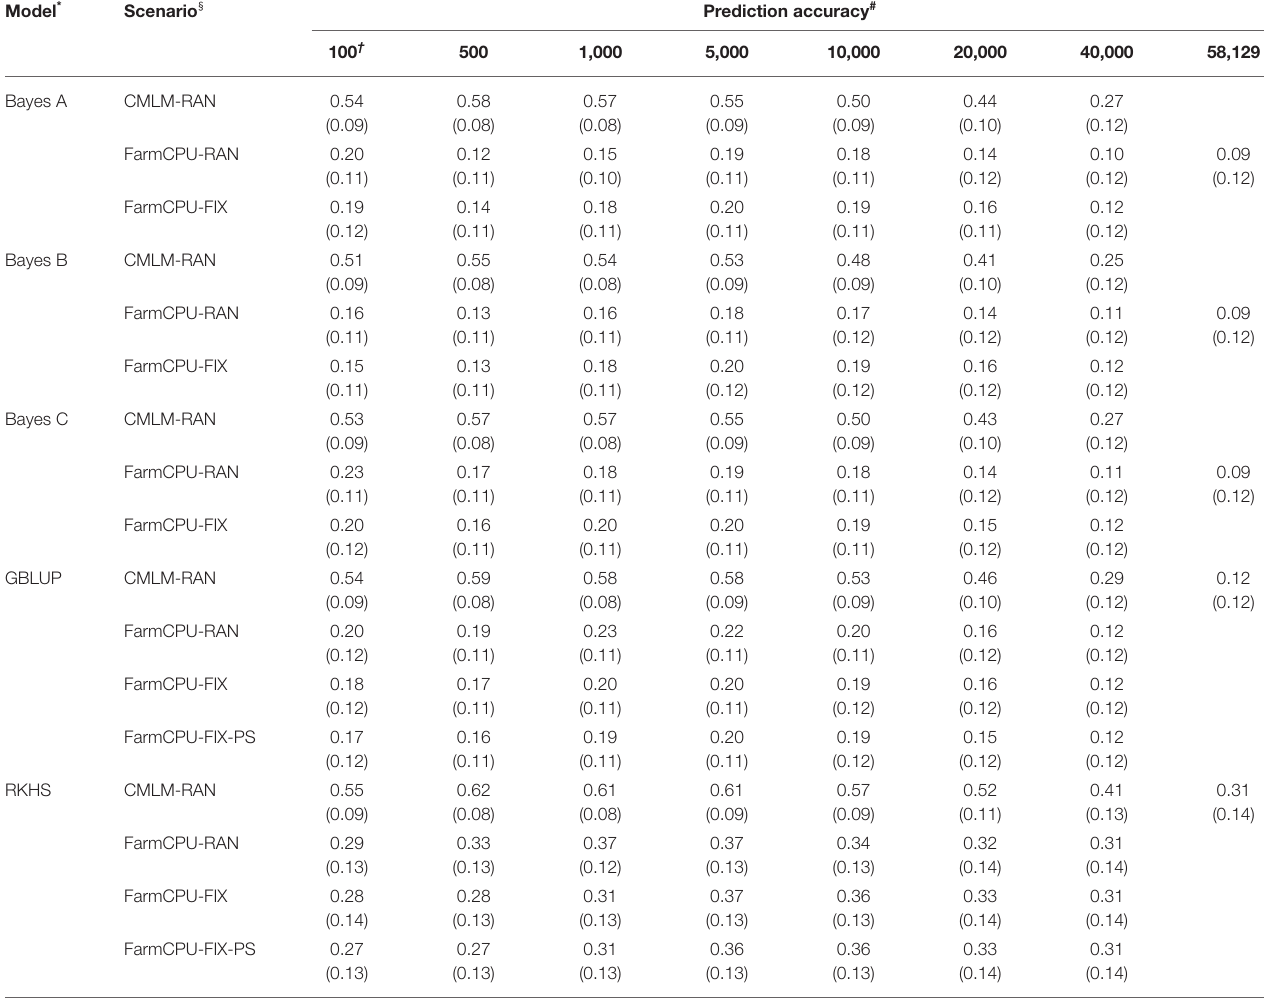
TABLE 3 | Prediction accuracy of random model, fixed model, and population structure model based on trait-associated markers in five prediction models for ear weight. Model